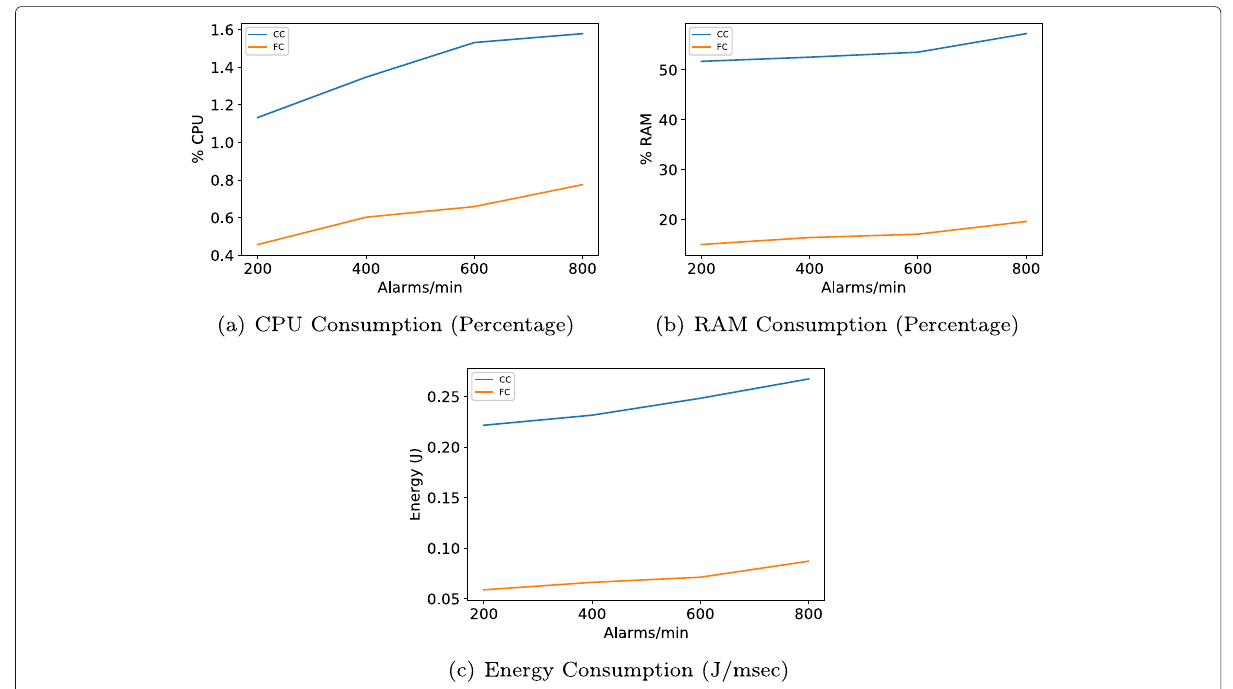
Fig. 11 Performance Breakdown at the core level - Fog Computing (FC) vs. Cloud Computing (CC)